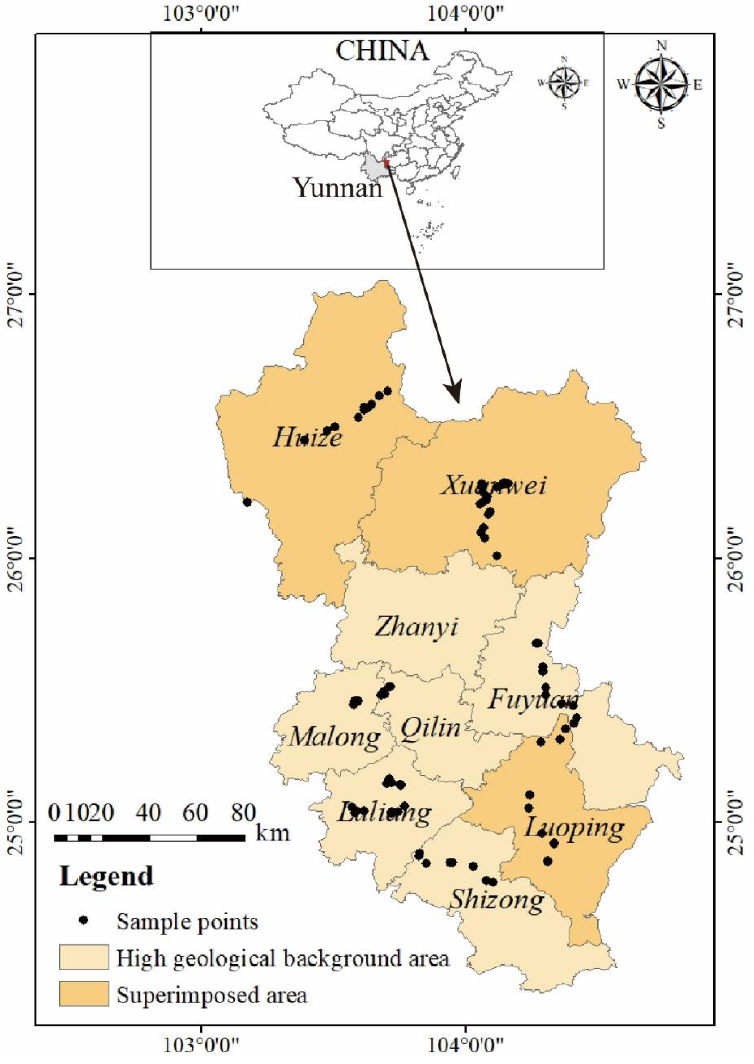
Figure 1. Distribution map of sampling sites .